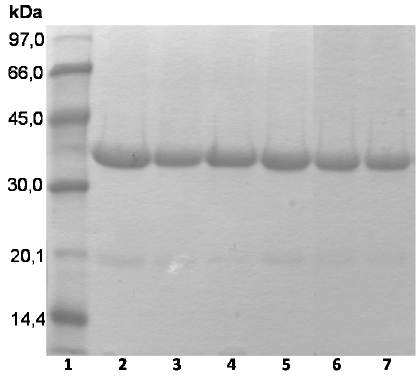
Figure 6. SDS-PAGE analysis of different CALB preparations after thermal inactivation in 5 mM buffer sodium phosphate at pH 7 and 65 °C. Experiments have been performed as described in section 2. Lane 1: Low Molecular Weight Marker, Lane 2: OC, Lane 3: OC inactivated, Lane 4: OCEDA, Lane 5: OCEDA inactivated, Lane 6: OCHDA, Lane 7: OCHDA inactivated.